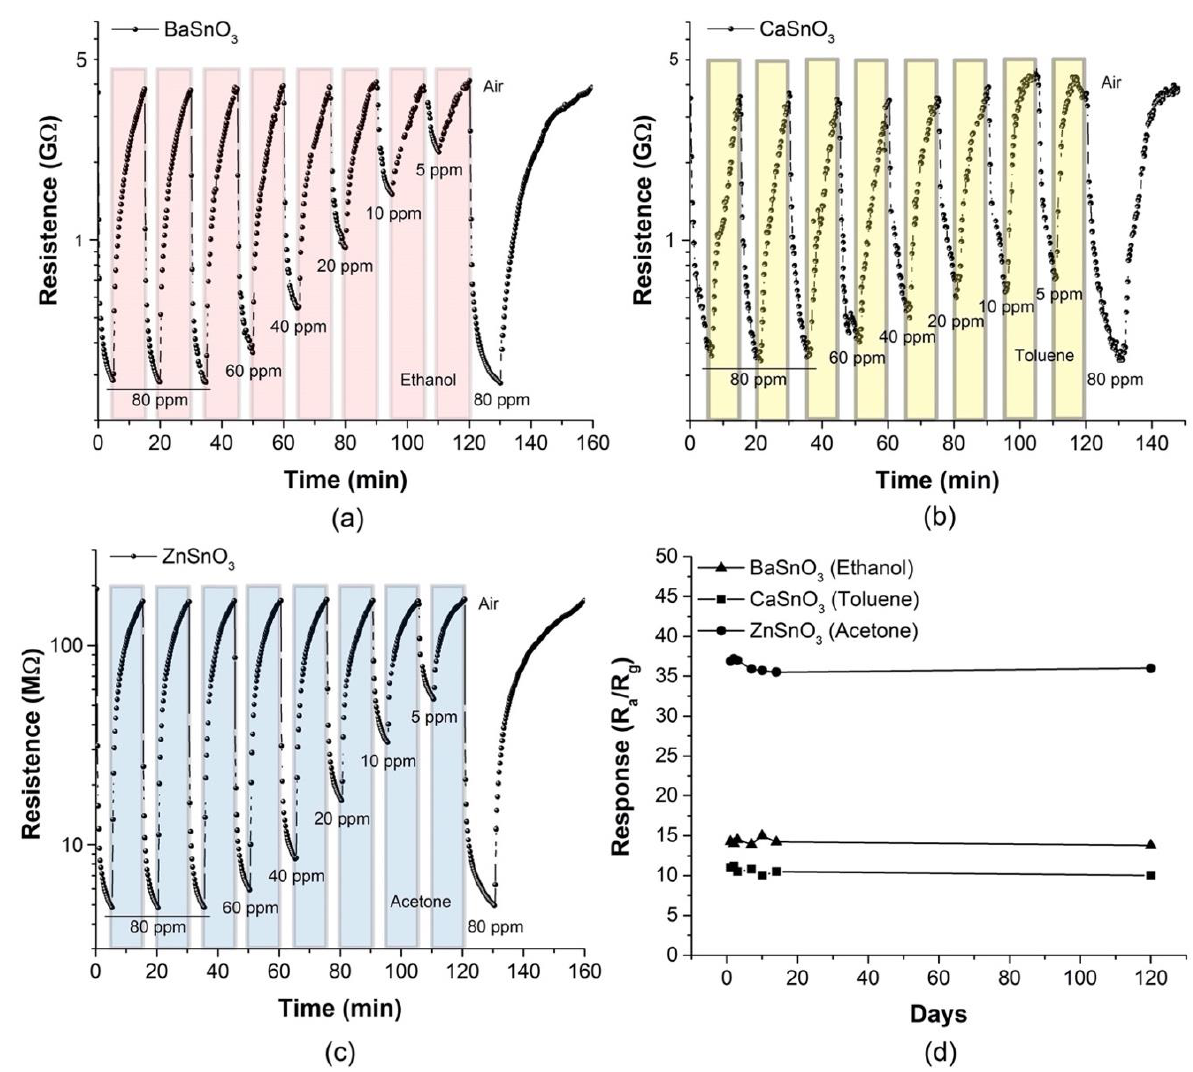
Figure 11. Dynamic response–recovery cycles of the ( a ) BaSnO 3 , ( b ) CaSnO 3 , and ( c ) ZnSnO 3 sensors, exposed to different concentrations of ethanol, toluene, and acetone, respectively. ( d ) Long-term stability of the sensors (to 80 ppm and 270 °C).